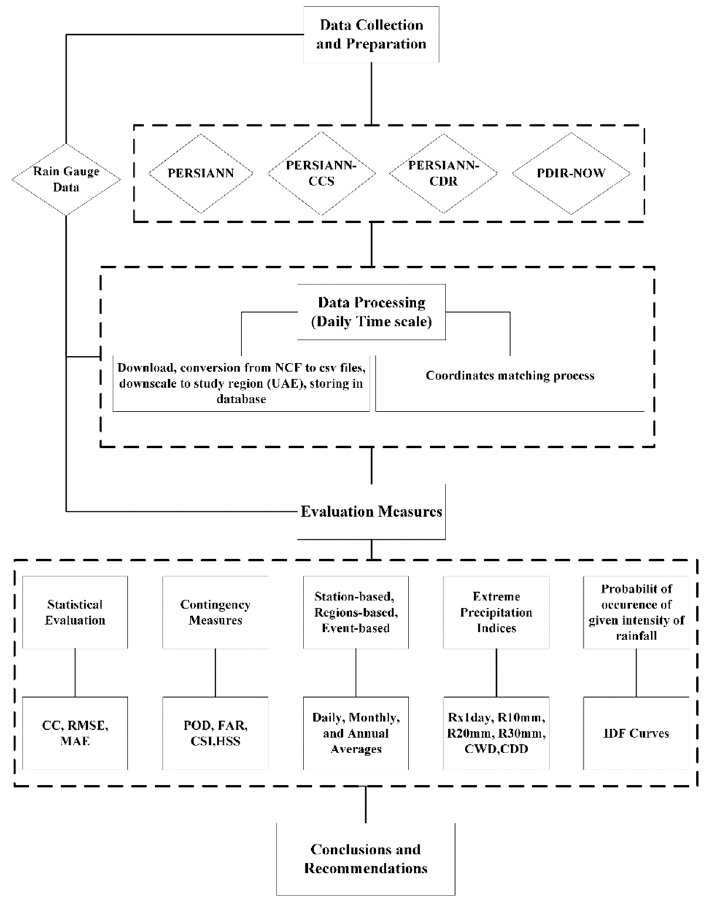
Figure 2. Flow chart for the data analysis